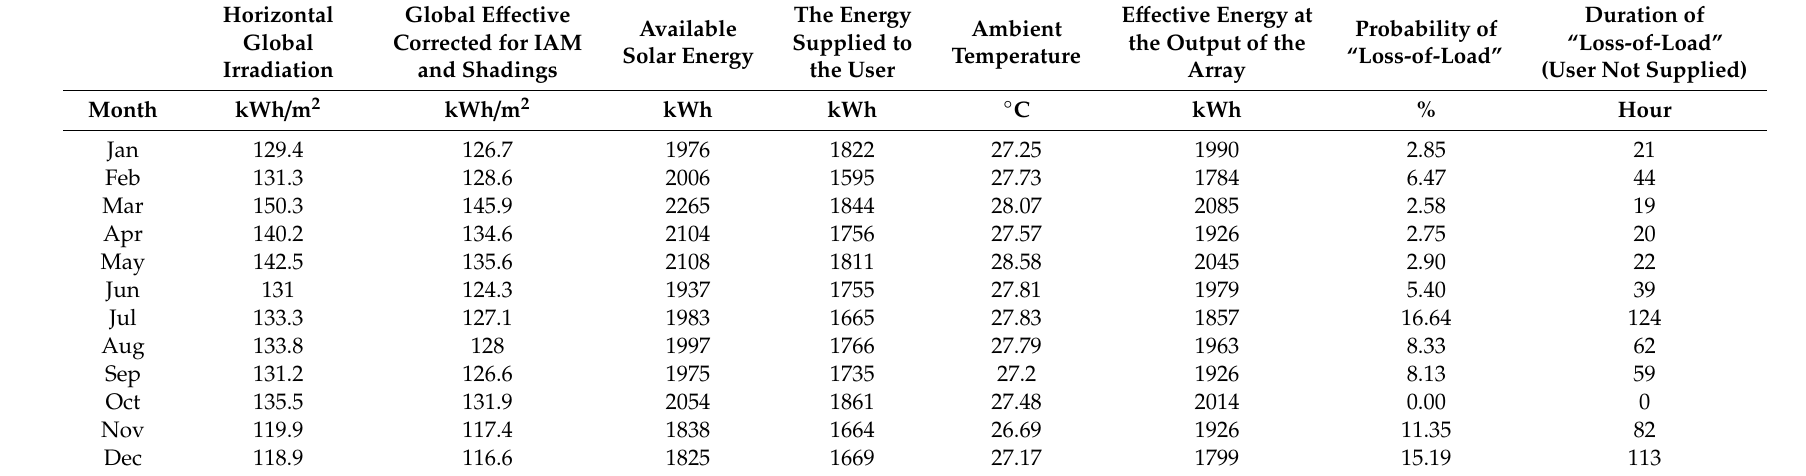
Table 2. Energy balance of the system.